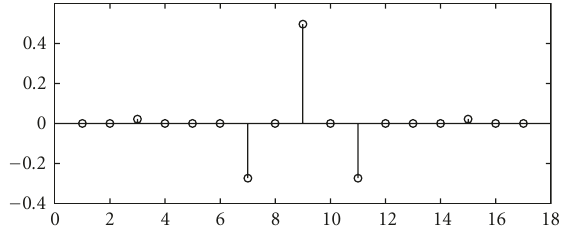
Figure 4: The 17 taps bandpass filter used as the linear channel in the Wiener system, generated in Matlab as